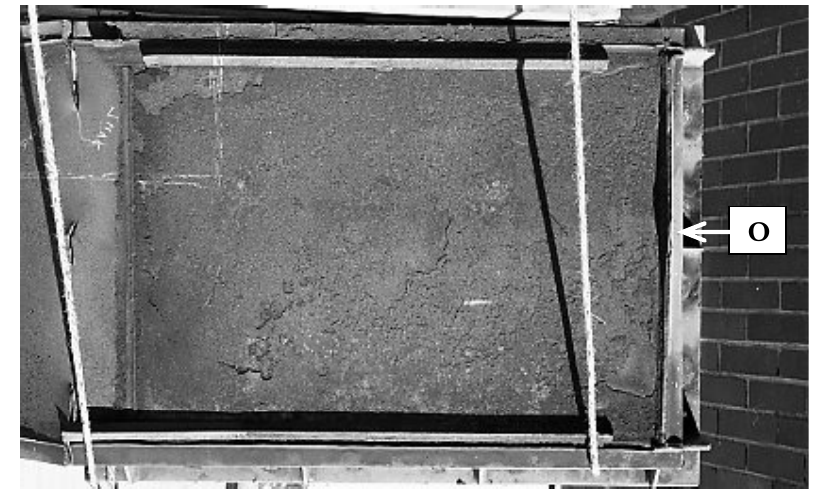
Figure 5: Fracture surface of the failed box section which led to collapse of the portal crane. The letter ‘O’ indicates the outer edge of the section, where the cracking